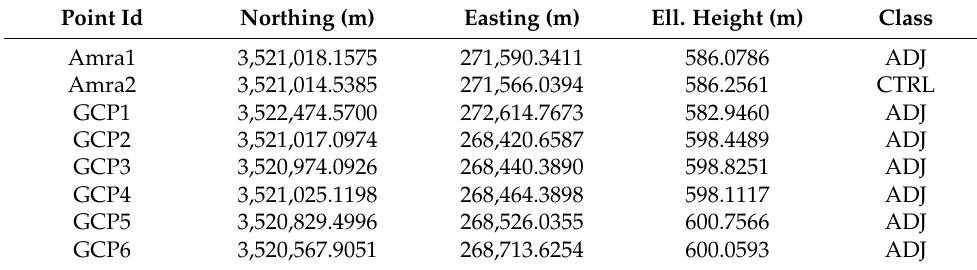
Table 1. Qaser Amra GCP-adjusted coordinates in UTM zone 37.